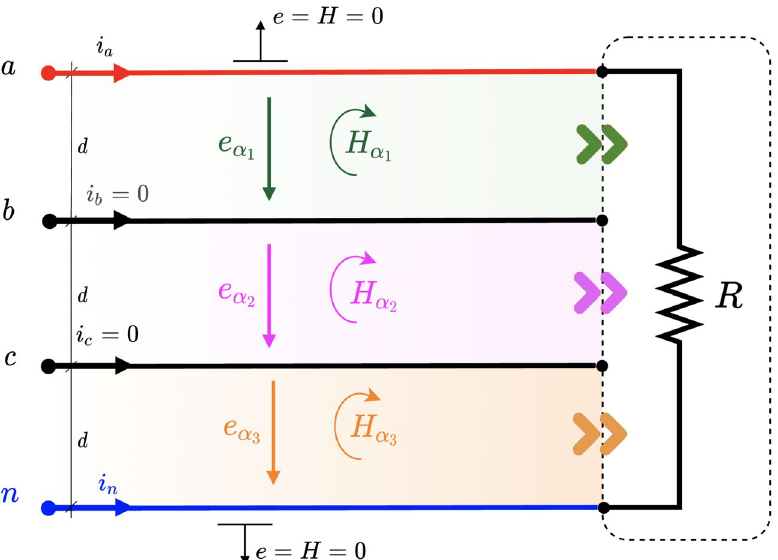
Figure 9. 4-wire unbalanced 3-phase circuit with resistor between line a and neutral n with 2 phases in